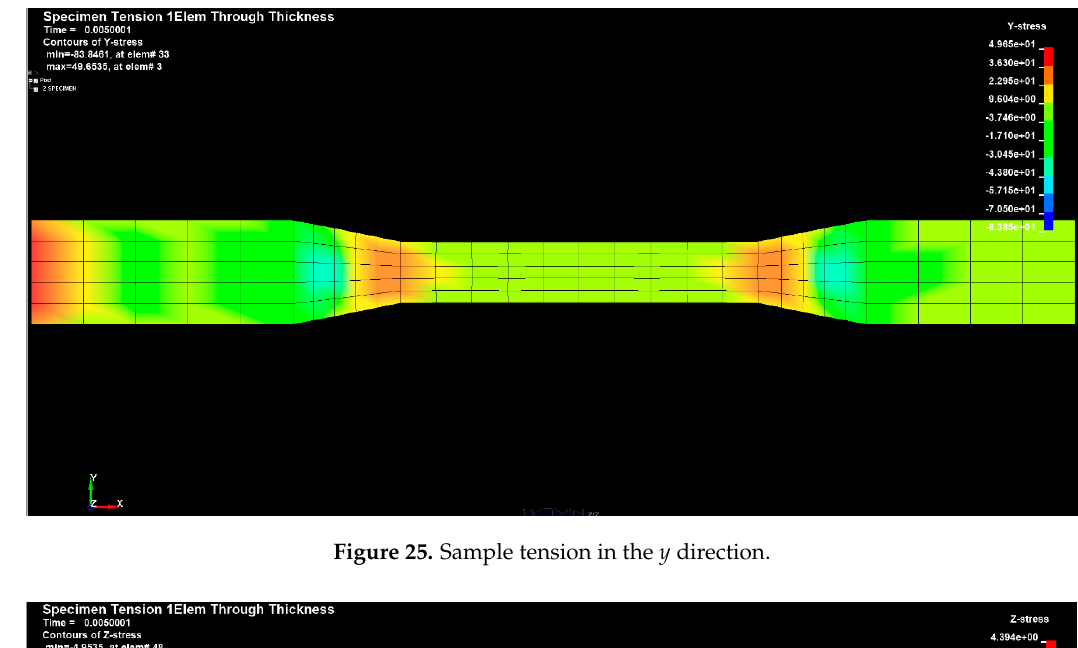
Figure 25. Sample tension in the 𝑦 direction.